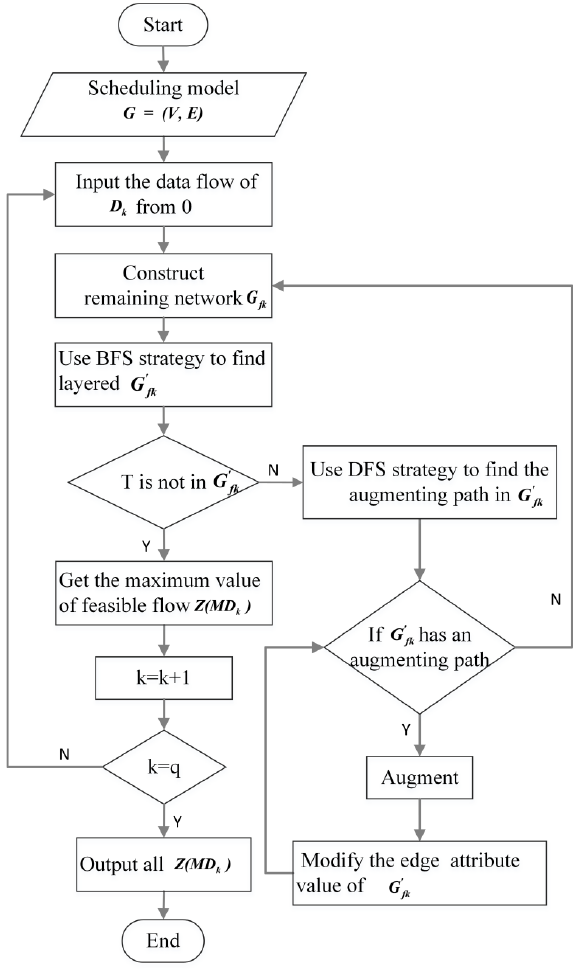
Figure 5. Flow chart of the Dinic algorithm.